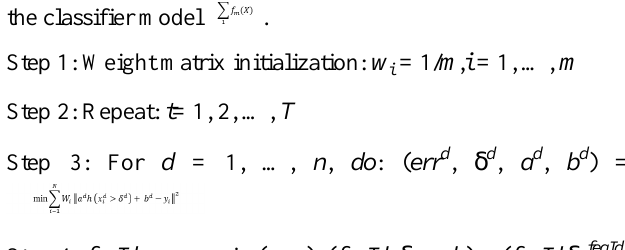
algorithm solution using singular value decomposition with the minimum